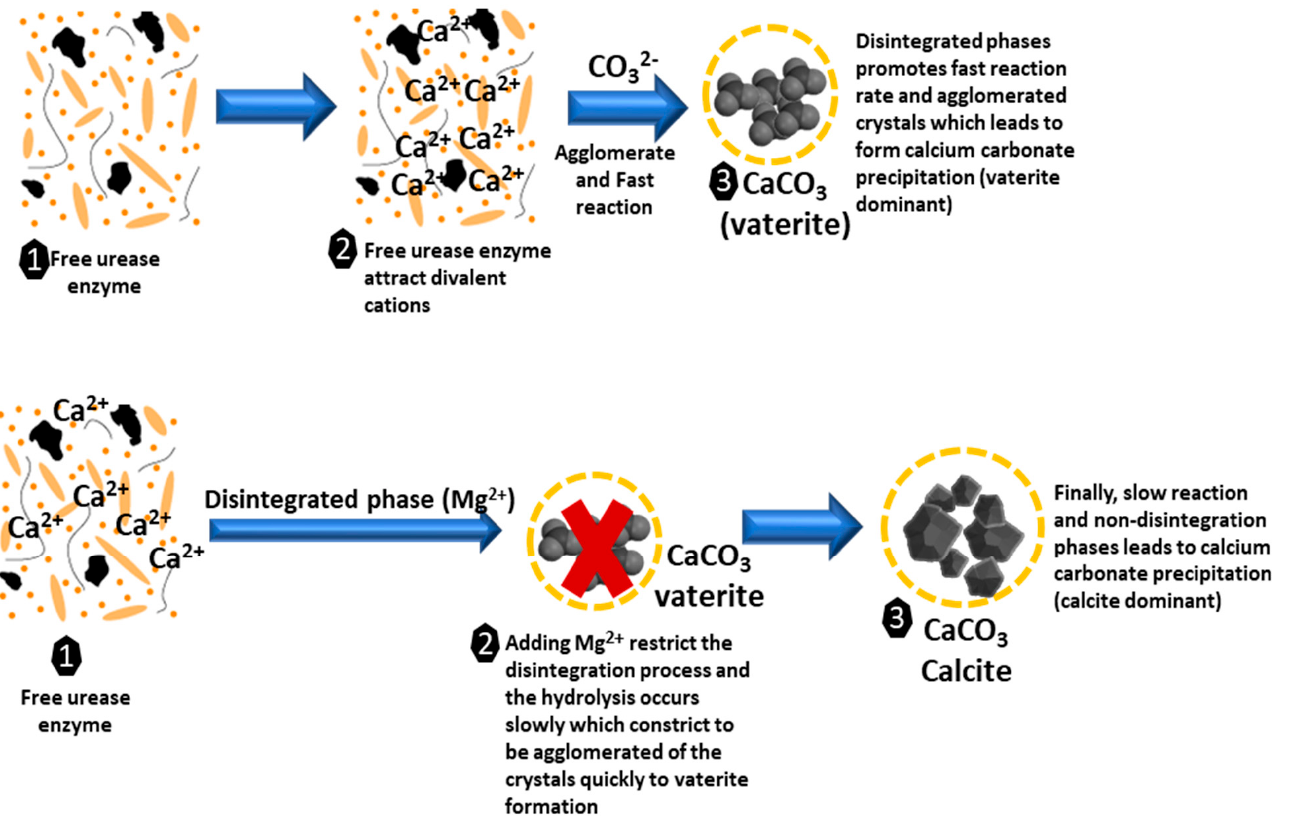
Figure 11. Schematic illustration of the CaCO 3 formation mechanism (calcite and vaterite) in contract with Mg 2+ /Ca 2+ ratios.